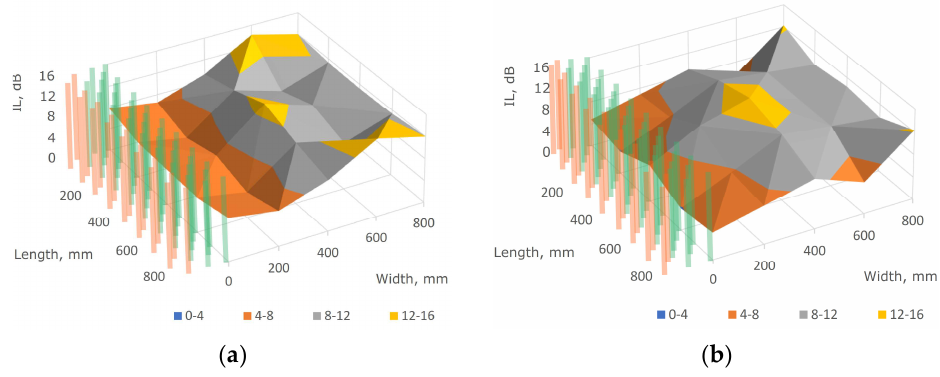
Figure 9. 3D view of the spatial distribution related to configuration 6 at 5 kHz ( a ) and 6.3 kHz ( b ). Distance between source and edge of barrier ( Xs ) is equal to 800 mm. Distance between receiver and edge of barrier ( Xr ) is variable and corresponds to 25 positions of a 200 × 200 mm grid.